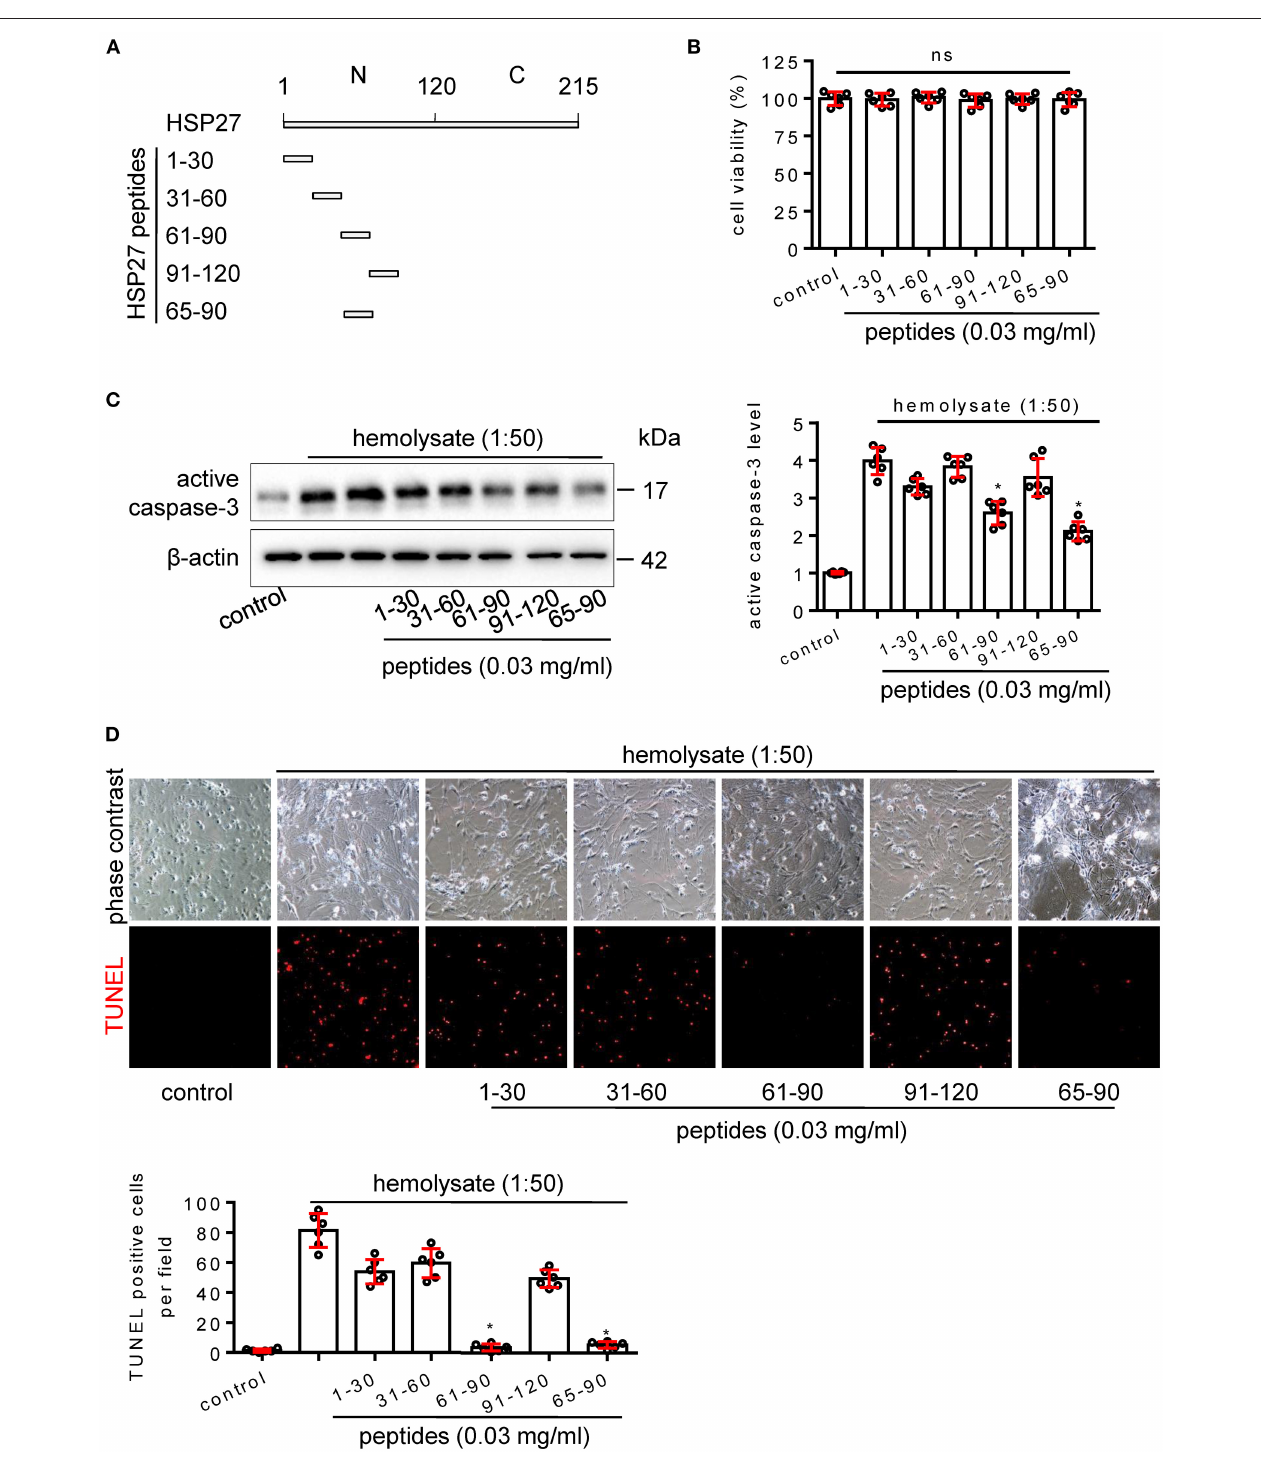
FIGURE 7 | Effect of HSP27 peptides on hemolysate-induced cell apoptosis in primary cortical neurons. (A) Schematic representation of various HSP27 peptides. (B) Hsp27 peptides have no effect on cell viability in primary cortical neurons; Cortical neurons were treated with indicated HSP27 peptides (0.03 mg/ml) in medium (1:50) for 24h. Cell viability was measured with Cell Counting Kit-8 (CCK-8) and normalized to control. (C,D) Cortical neurons were treated with hemolysate in medium (1:50) or plus indicated HSP27 peptides (0.03 mg/ml) for 24h. (C) Active caspase-3 levels in each group were detected by Western blot, β -actin serves as a control, and quantification of optical density was normalized to control. (D) Representative images of cortical neurons (phase contrast, × 200) and TUNEL staining (red, × 200), and quantification of TUNEL-positive cells from each group was performed. Data are mean ± SD, n = 6, * p < 0.05 vs. hemolysate treatment, ANOVA with Bonferroni’s multiple comparisons